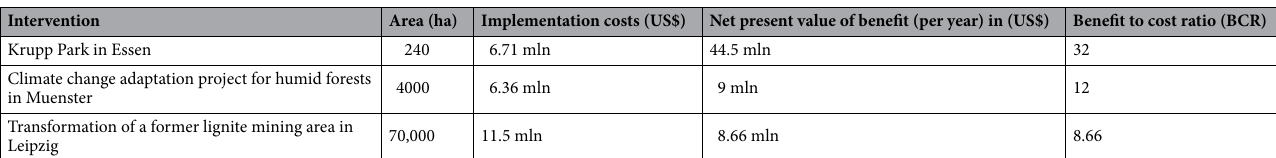
Table 1. Benefit-to-cost analysis results for selected NBS interventions in Germany. The 240 ha Krupp Park in Essen (Germany) was restored to improve environmental conditions and its accessibility for recreation, biodiversity and to extend urban nature networks in the city. The park returns US$32 of social value to residents for each US$ invested. A 4000 ha climate change adaptation project for humid forests in Muenster (Germany) with total implementation costs of US$ 3.63 mln returned US$ 12 of social value for each dollar invested. Finally, the transformation of a former lignite mining area in Leipzig (Germany), covering 70,000 ha and offering CO2 reduction, climate regulation, improved quality of urban water/air and recreation, returned US$ 3.45 of total social value for each invested dollar for a total implementation costs of US$ 11.5